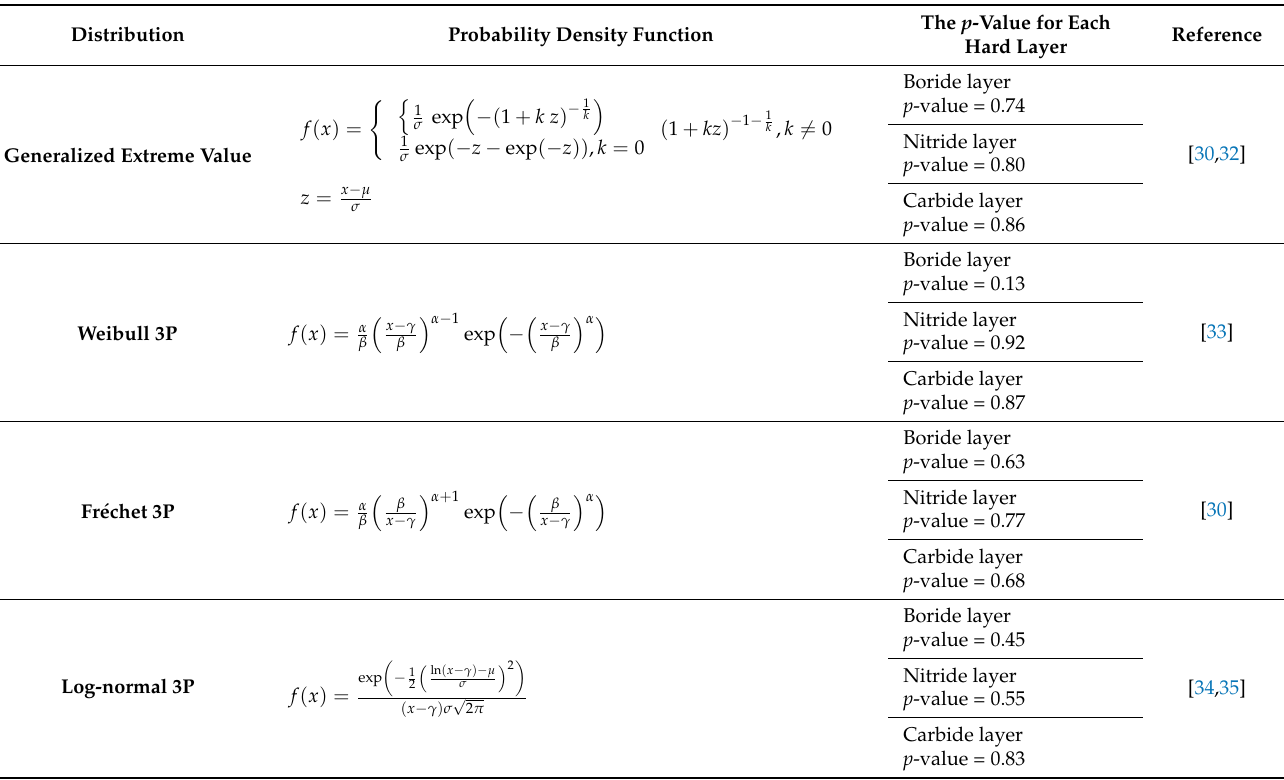
Table 9. Probability density function studied for microhardness observations in different hard layers.